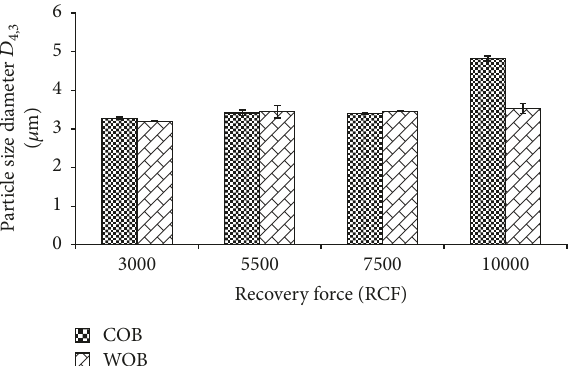
Figure 6: Average particle sizes of both crude oil body (COBs) and washed oil body (WOBs) emulsions obtained using different centrifugal forces.